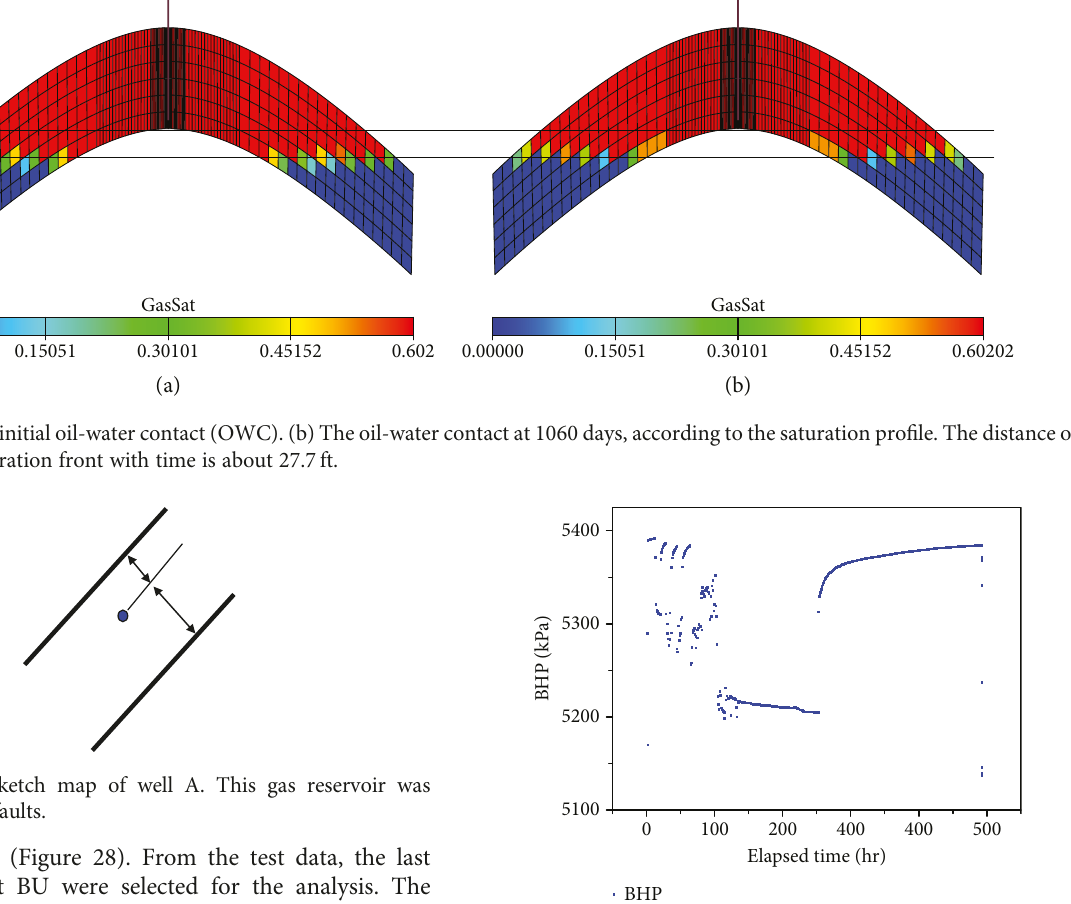
Figure 25: The test history of well A. The last BU was selected for the analysis.